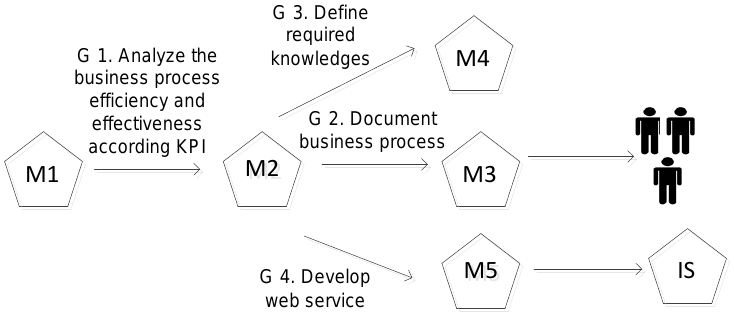
Figure 8. The modeling of the business process “Crediting the legal persons” according to different modeling